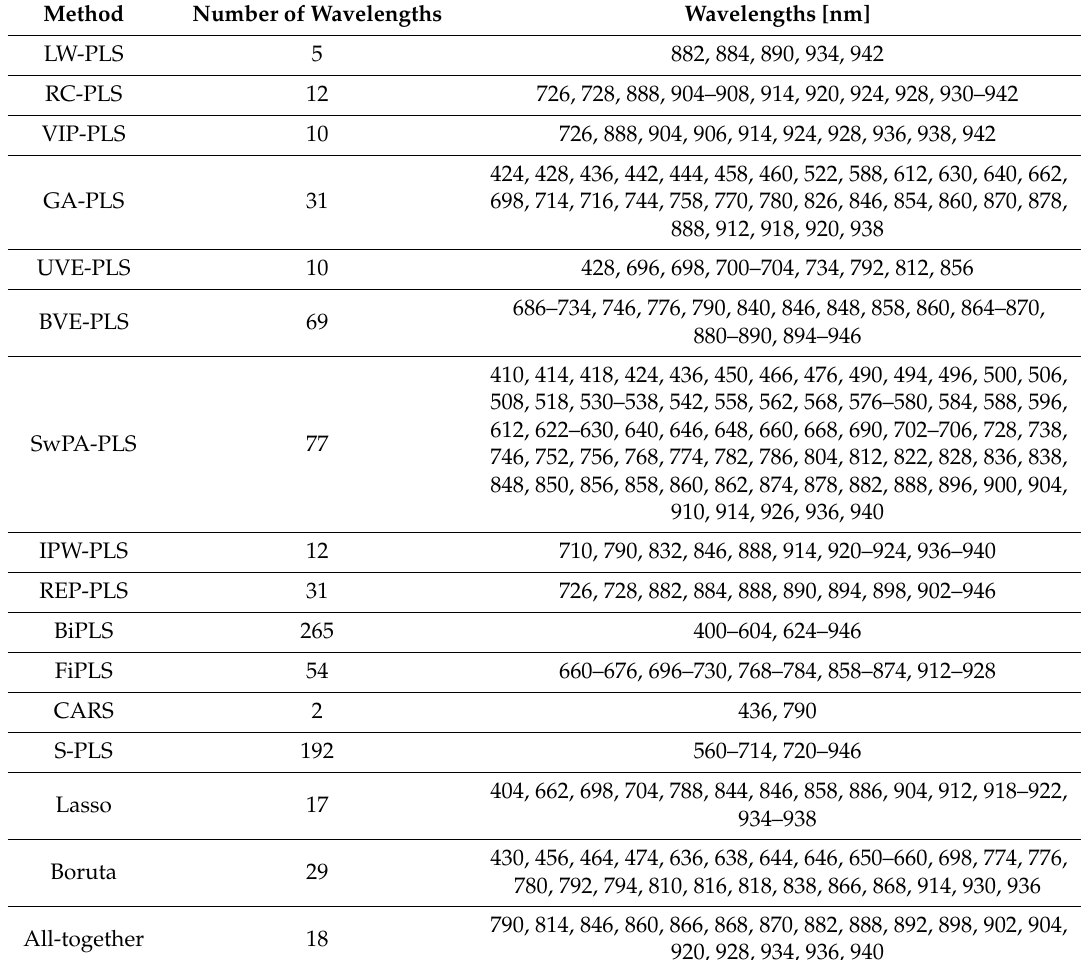
Table 4. Wavelengths selected by di ff erent